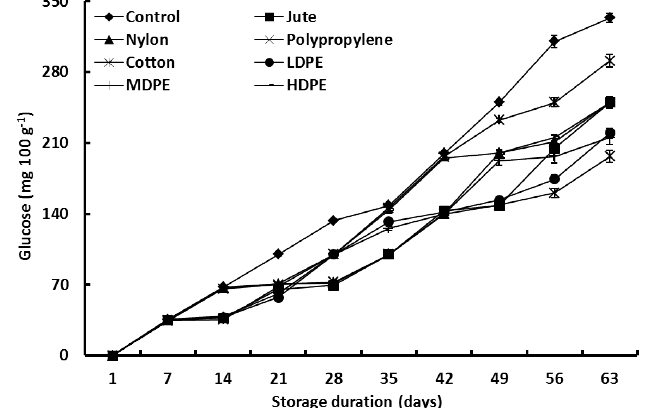
Fig. 2: Glucose content in stored potato tubers stored using different pa- ckaging materials was lowest by the end of the storage period when stored in polypropylene packages. Vertical bars show ±SE of means (n-3). Interaction between storage intervals and packaging materials was significantly different at p ≤